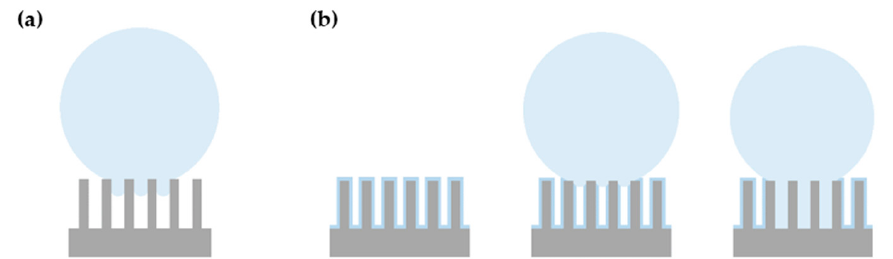
Figure 20. ( a ) First droplet deposited on the textured surface; ( b ) chemisorbed water on the surface and/or surface chemistry changes allowing anchorage of the next deposited droplet.